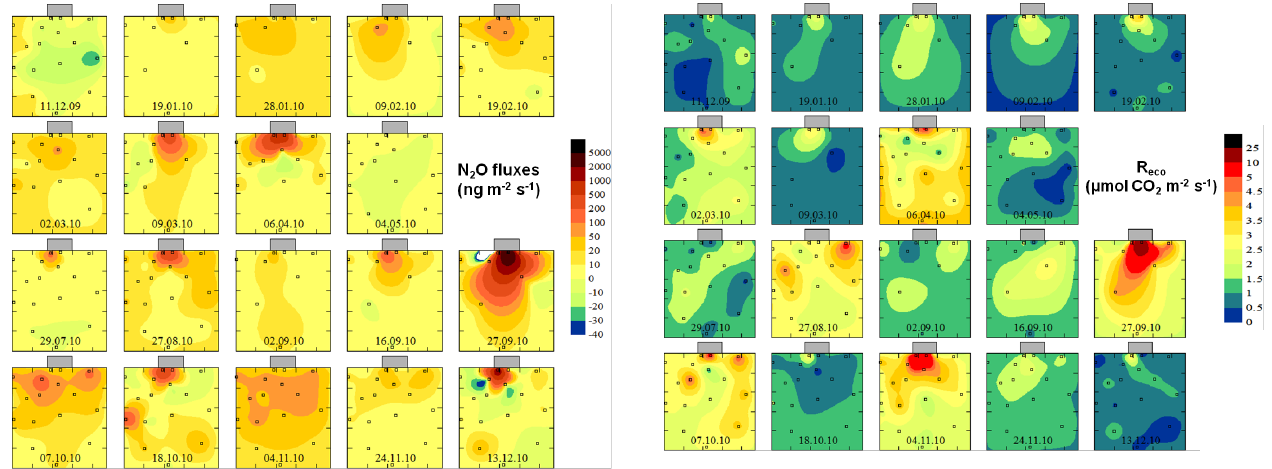
Fig. 5. Spatially interpolated (kriging method) maps of ecosystem respiration R eco (not including broiler respiration). Comments as in Fig. 3. Plot-scale N 2 O fluxes ranged from − 2.1 to +31.8 ng N 2